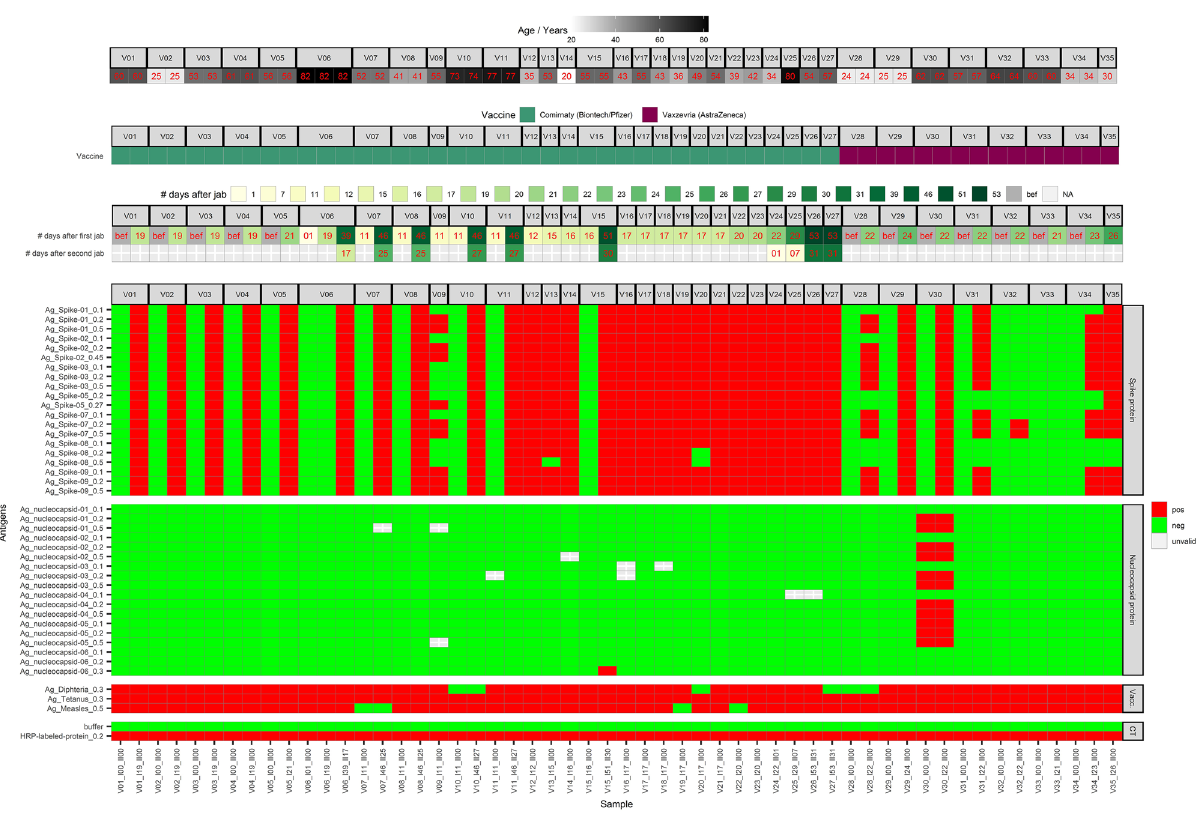
Figure 4. The SARS-CoV2-VAC antigen microarray was used to investigate immunization status after COVID- 19 vaccination. Shown are the results of 35 subjects tested who received BioNTech/Pfizer’s Cormirnaty vaccine and 8 subjects tested who received AstraZeneca’s Vaxzevria vaccine. Sera taken prior